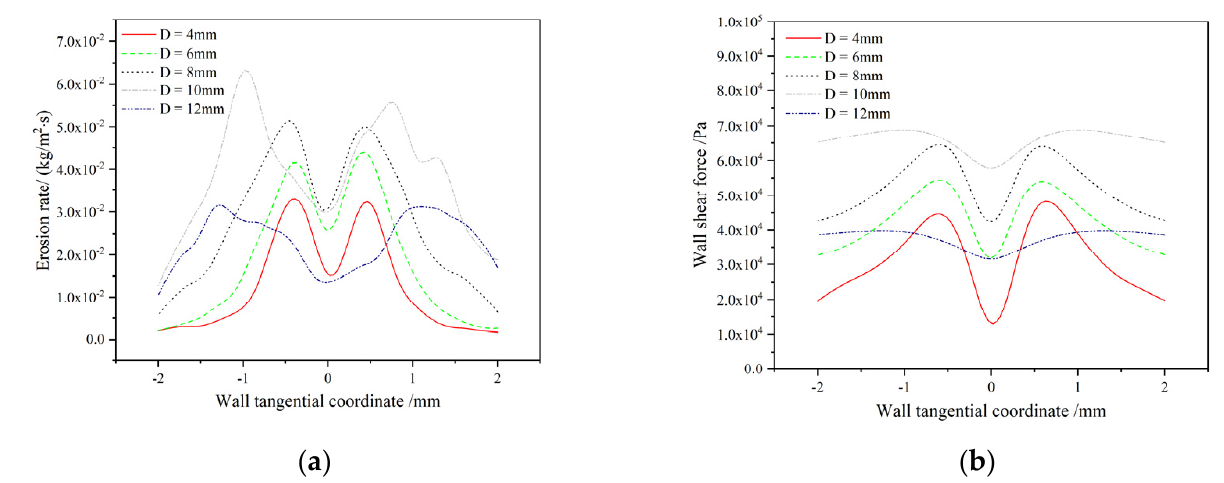
Figure 9. Simulation of workpiece wall removal under different impact distances. Wall erosion rate ( a ). Wall shear force ( b ).